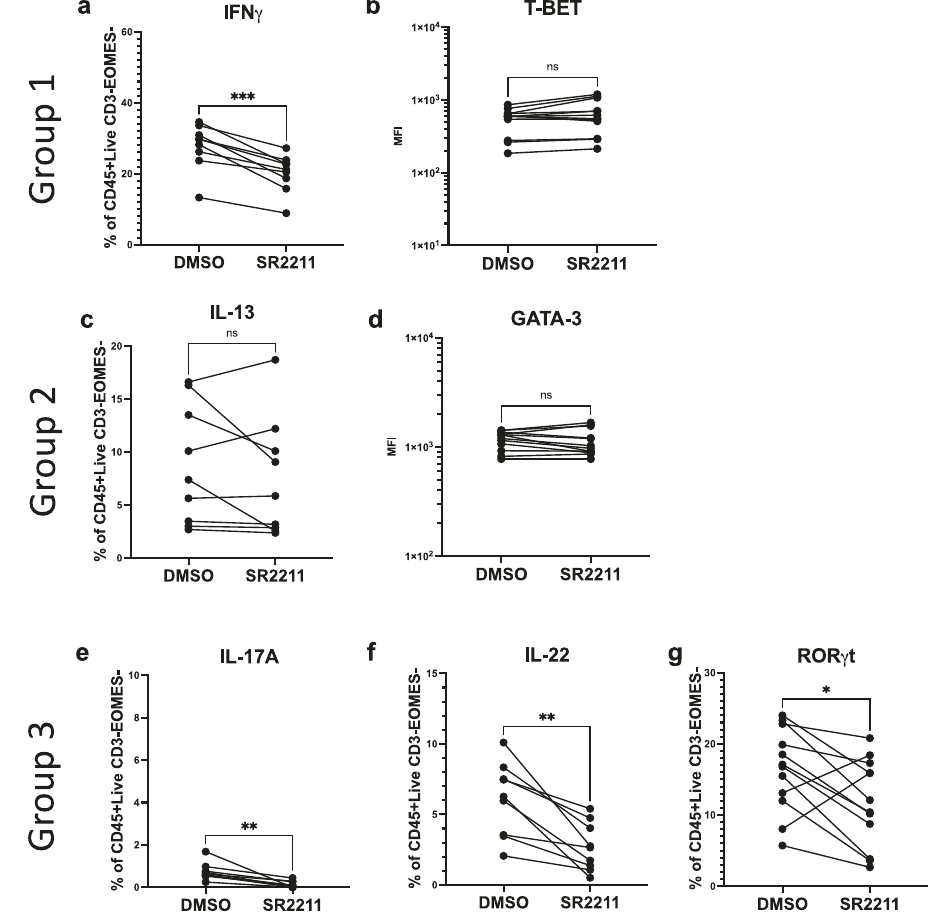
Fig. 3 | Impact of RORC inhibition for ILCP differentiation. Analysis of cytokine ( n =9) and transcription factor ( n =12) expression in differentiated human ILCP afteradditionofeither0.01%DMSOorSR2211(10uM)wasassessedasdescribedin Fig. 1. Representative plots in Supplementary Fig. 4. Expression of Group 1 ILC associated factors ( a ) IFN γ and b T-BET. Expression of Group 2 ILC associated factors( c )IL-13( d )andGATA-3.ExpressionofGroup3ILCassociatedfactors( e )IL-